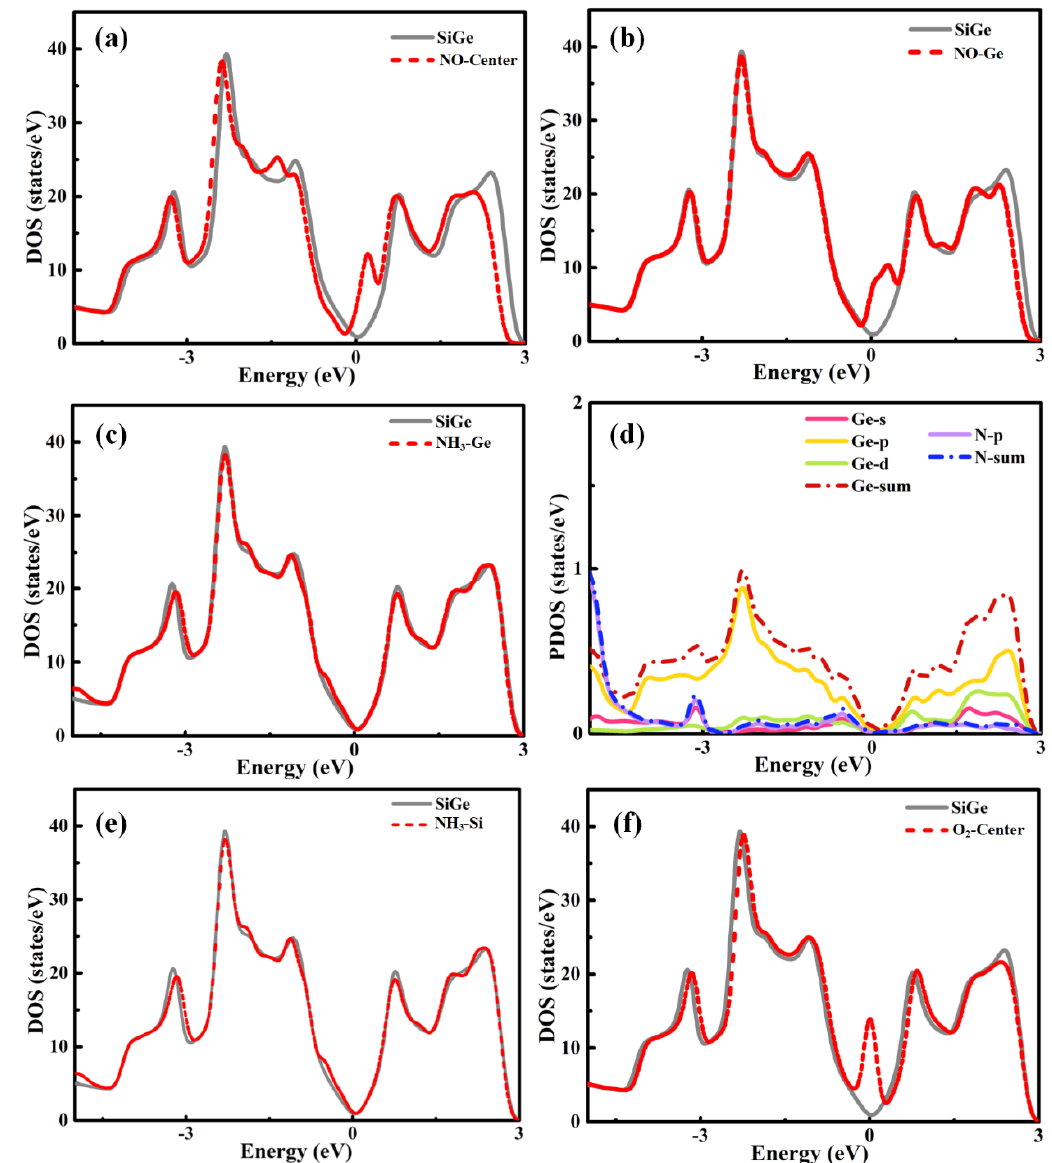
Figure 4. Total density of states for ( a ) NO-center, ( b ) NO-Ge, ( c ) NH 3 -Ge, ( d ) partial density of states (PDOS) for NH 3 -Ge adsorptions, and ( e ) NH 3 -Si, ( f ) O 2 -center.